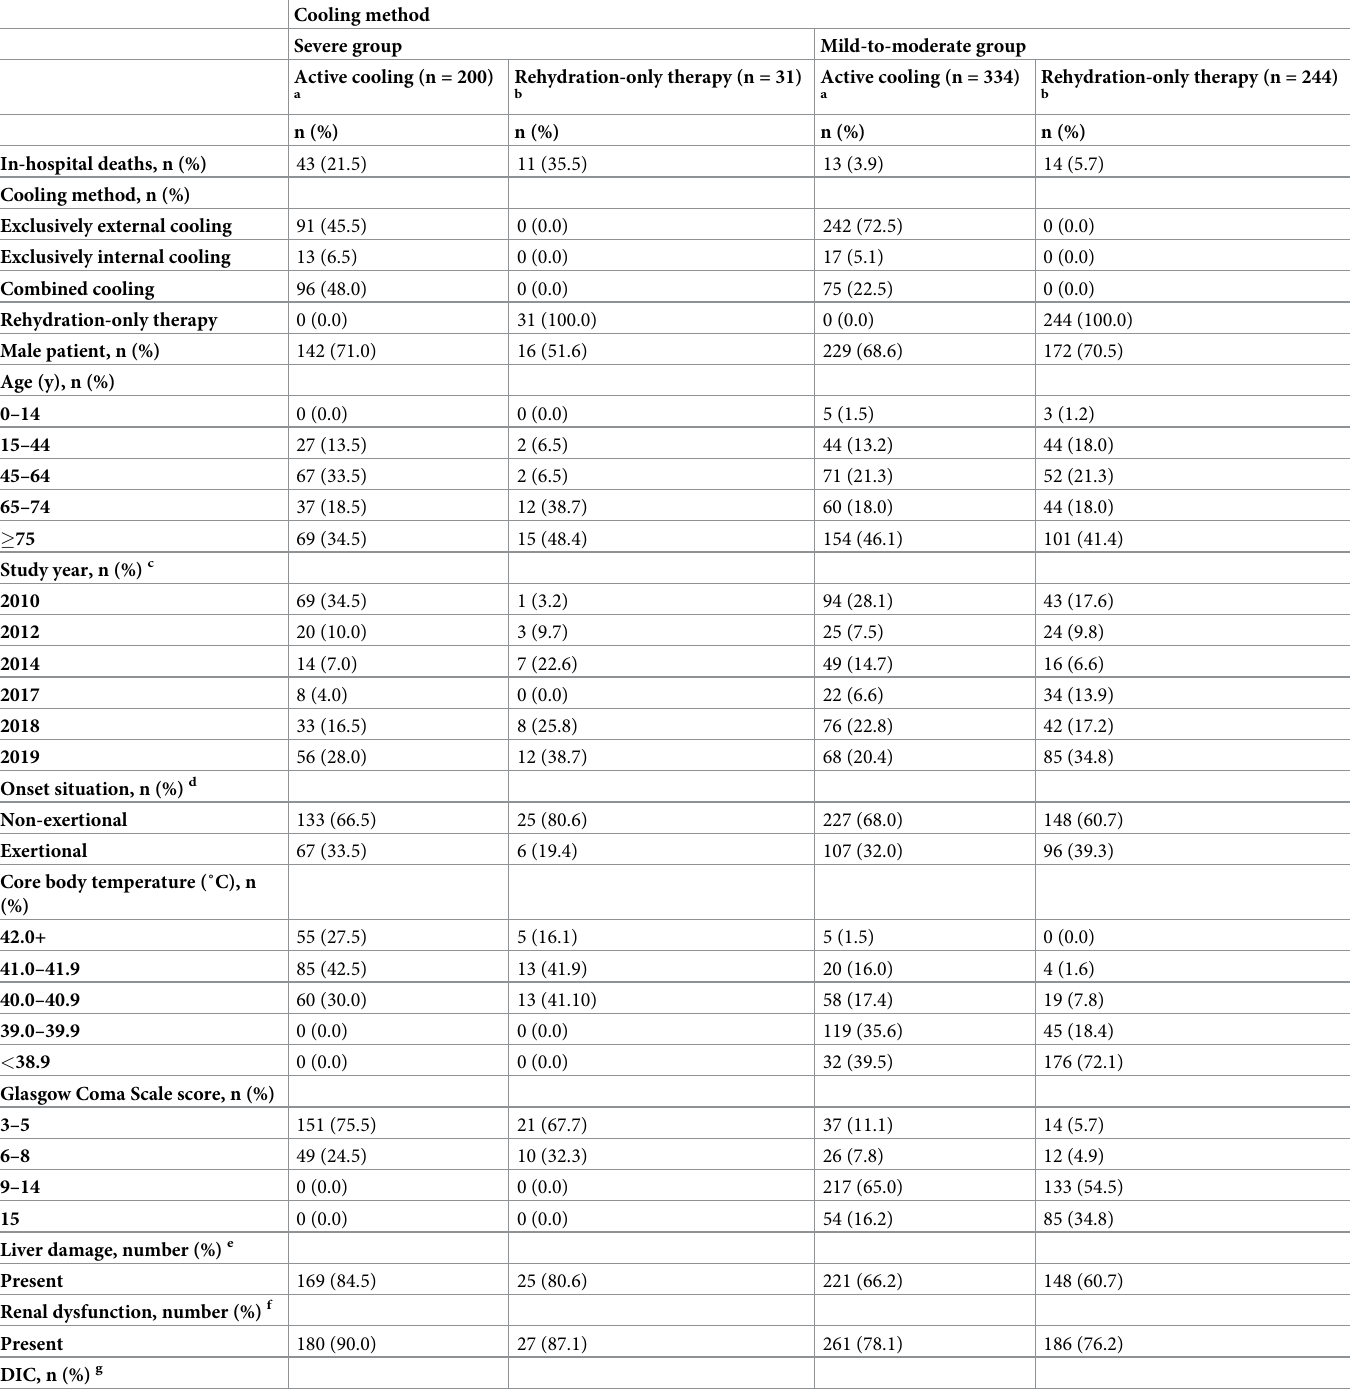
Table 1. Distribution of factors potentially associated with patient prognosis after heat illness